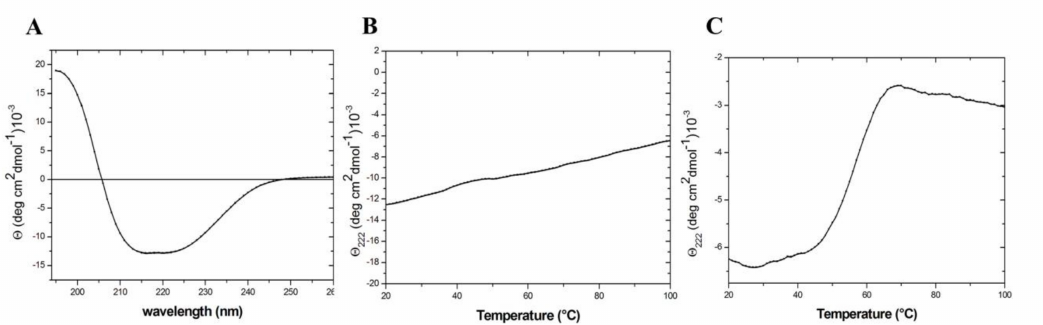
Figure 3. Spectroscopic characterization of TmArgBP 20 − 233_F76W : Far-UV circular dichroism (CD) spectrum ( A ), thermal denaturation curves in phosphate bu ff er saline (PBS) bu ff er ( B ) and in PBS bu ff er containing 4.0 M GuHCl ( C ).